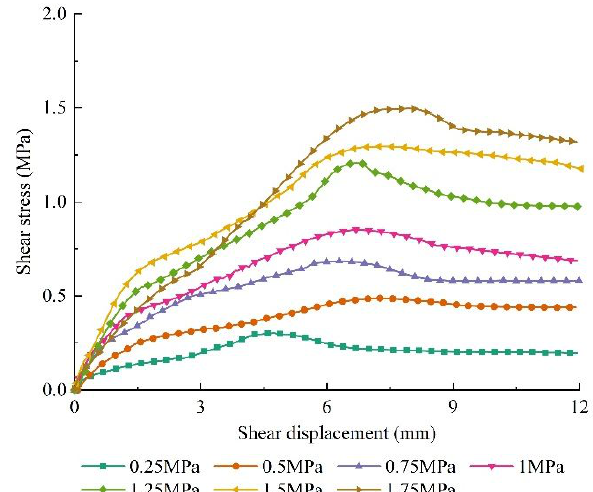
Figure 17: Shear stress-displacement curve of double saw-tooth